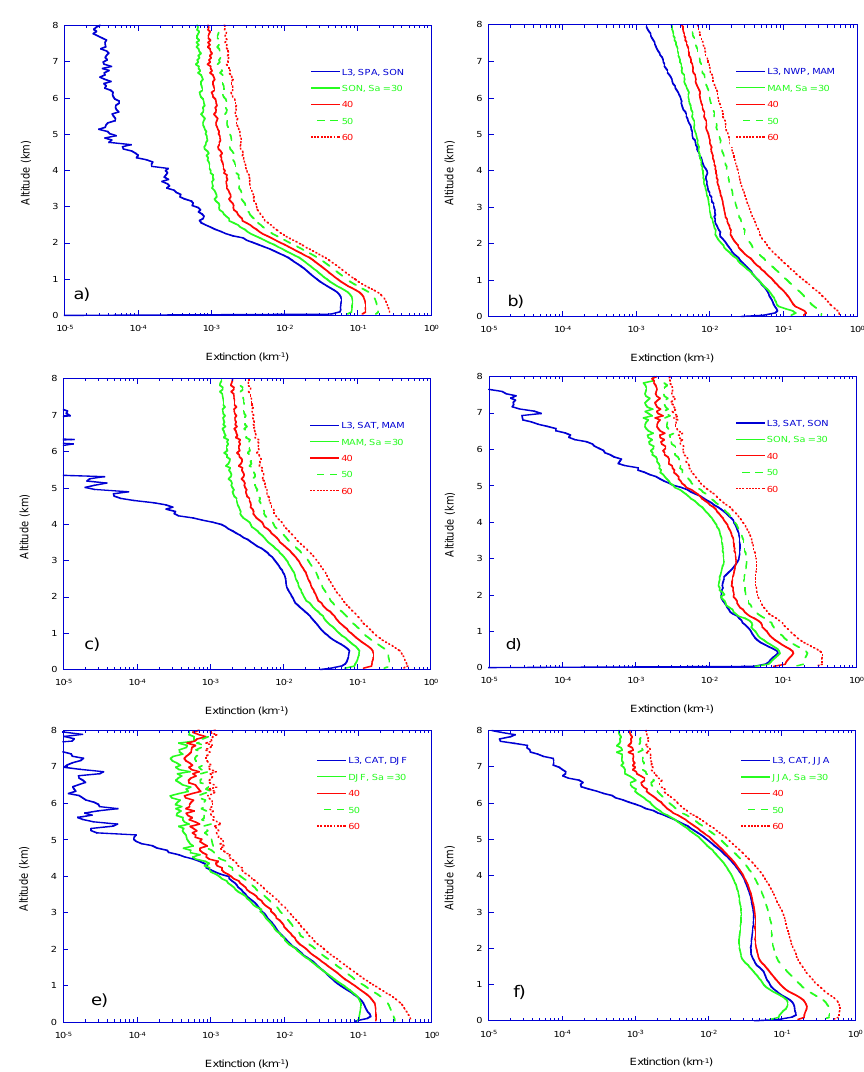
Fig. 17. Comparison of aerosol profiles derived from CALIOP Level 2 data with profiles from full-column retrievals using fixed lidar ratios of 30, 40, 50, and 60 sr. (a) SPA, SON; (b) NWP, MAM; (c) SAT, MAM; (d) SAT, SON; (e) CAT, DJF; (f) CAT,